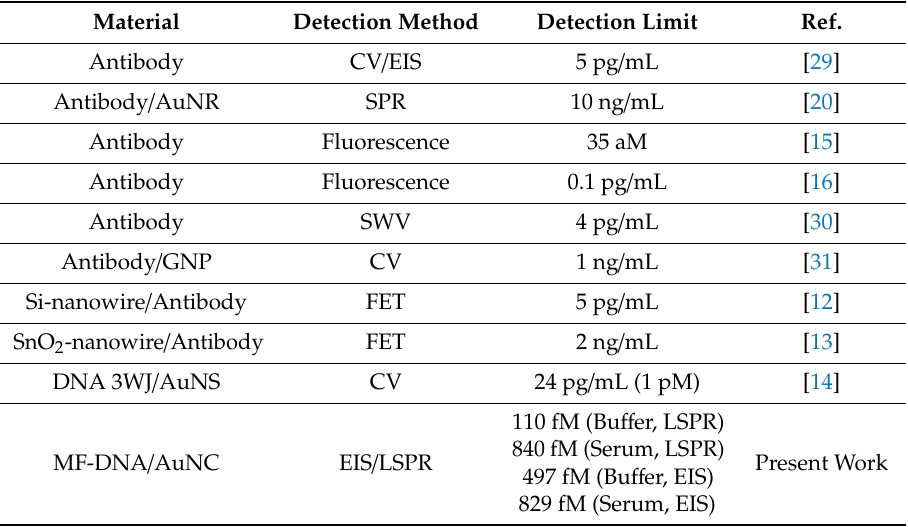
Table 1. Comparison of the fabricated biosensor with other biosensors for troponin I detection in terms of materials, detection method, sensitivity (loss on drying, (LOD)).